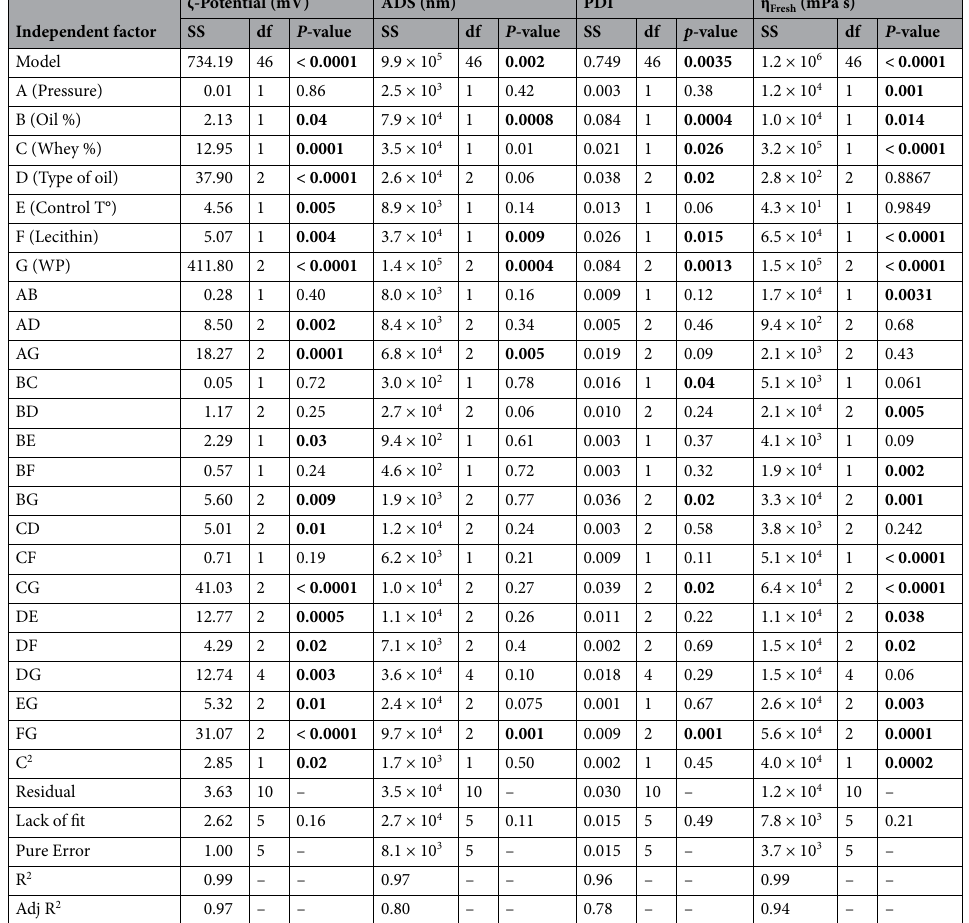
Table 2. ANOVA for the adjusted variables to response optimization design: ζ, ADS, PDI, and ƞ for fresh emulsions. Values in bold represent p values lower than 0.05 which have a significant effect